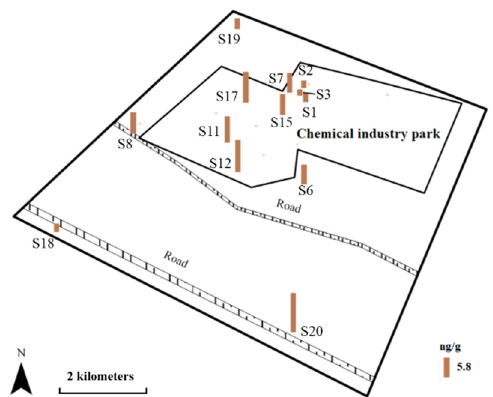
Figure 4. The distribution of total VOCs concentrations in soil at the study area.